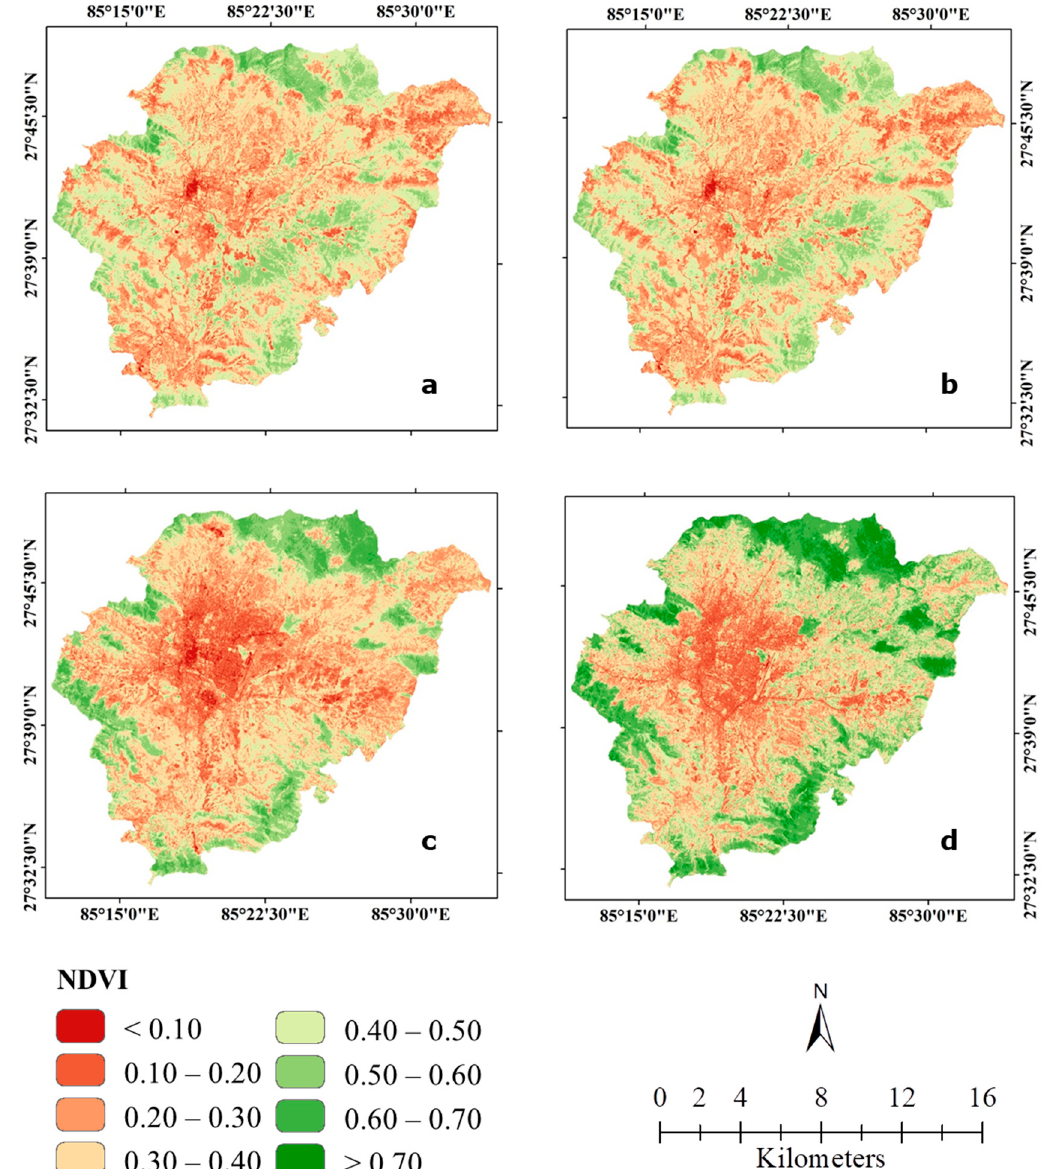
Figure 7. Spatial distribution of Normal Difference Vegetation Index (NDVI) for Kathmandu during, ( a ) 1988; ( b ) 1998; ( c ) 2008; ( d ) 2018. The correlations between LST and NDVI were significantly negative for all time points ( p < 0.001), declining from − 0.67 in 1988, to − 0.80 in 2018, but increasing in 1998 to − 0.65 (Table 4 and Figure A2). It was very clear that reduction in vegetation cover resulted in higher LST and vice versa (Figure 4). Mean NDBI also declined from − 0.02 in 1988, to 0.11 in 2018 with an increase in 2008 to − 0.06 (Table 4). The highest values for NDBI were in the central part in the Valley at each time-point because of densely built-up areas of Kathmandu City, Latlipur, Bhaktapur, and Madhyapur Thimi, whereas the lowest NDBI values were in some central and eastern parts of the Valley, such as Shivpuri Nagarjun National Park, Nagarjun Forest Reserve, Godavari Forest, and Bhandarkhal Jungle because of the high density VL (Figure